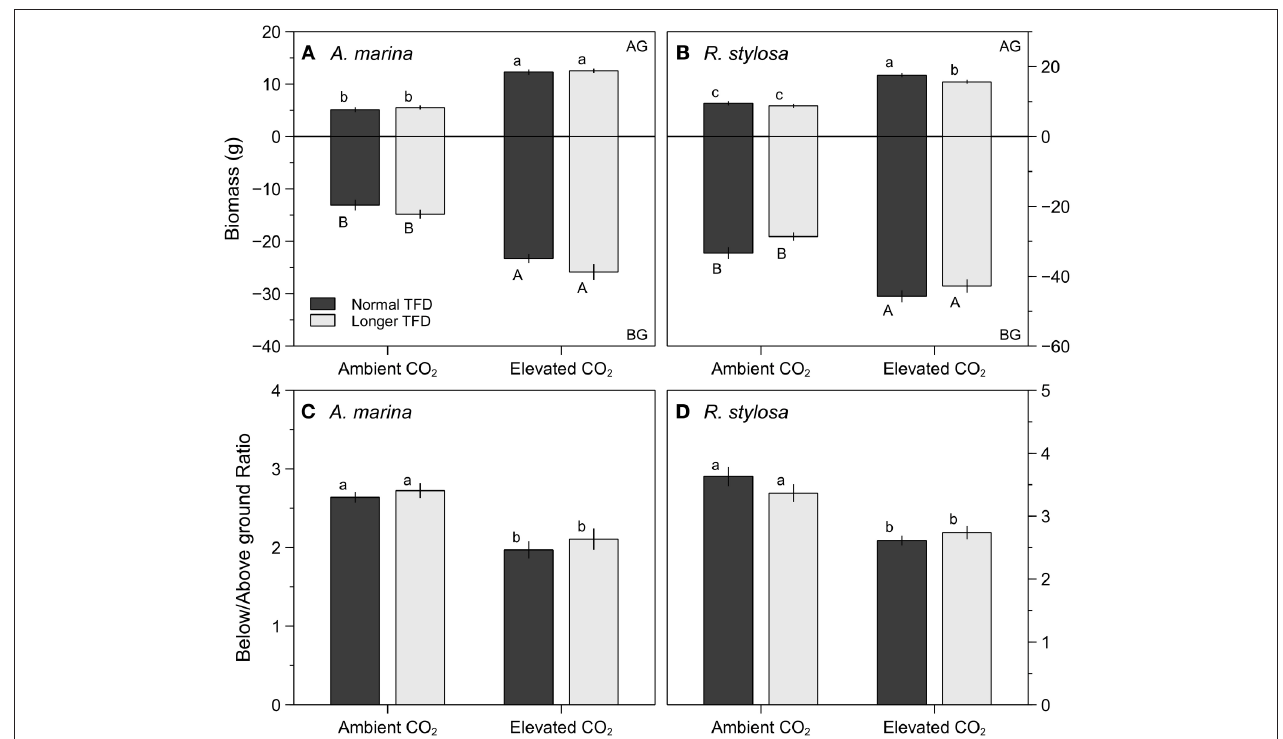
FIGURE 3 | Final above ground (AG) and below ground (BG) biomass (g), and below/above ground biomass ratios of A. marina (A,C) and R. stylosa (B,D) grown in ambient or elevated CO 2 , and under normal (dark-gray bars) and longer TFD (gray bars), for 12 months. Values are means ± SEM ( n = 30). Different letters indicate significant differences ( p < 0.05).